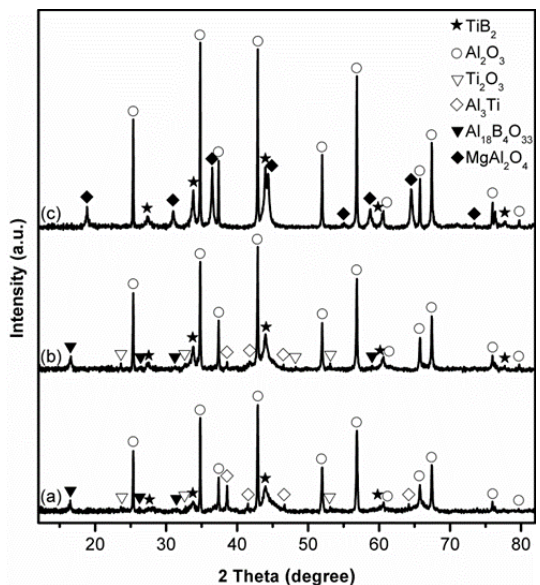
Figure 1. XRD patterns of stoichiometric samples after 4 h firing at 850 °C in: ( a ) KCl, ( b ) NaCl, and ( c ) MgCl 2 .